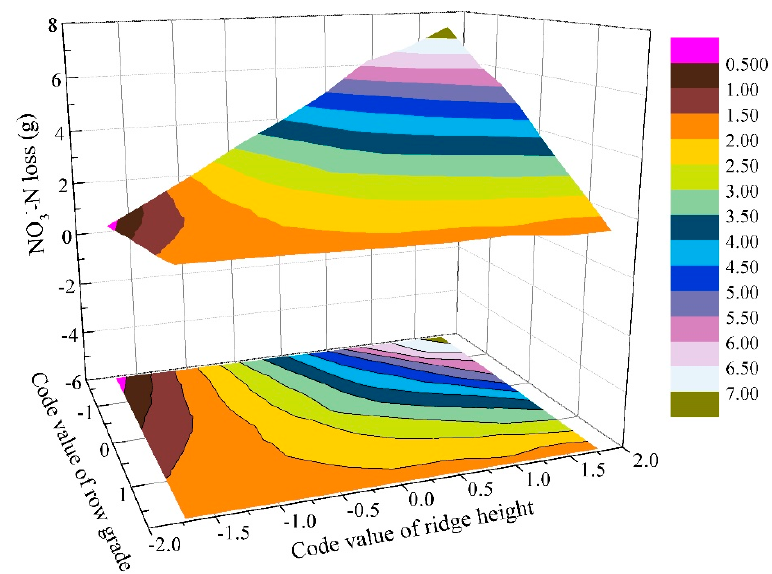
− –N * row grade on NO 3